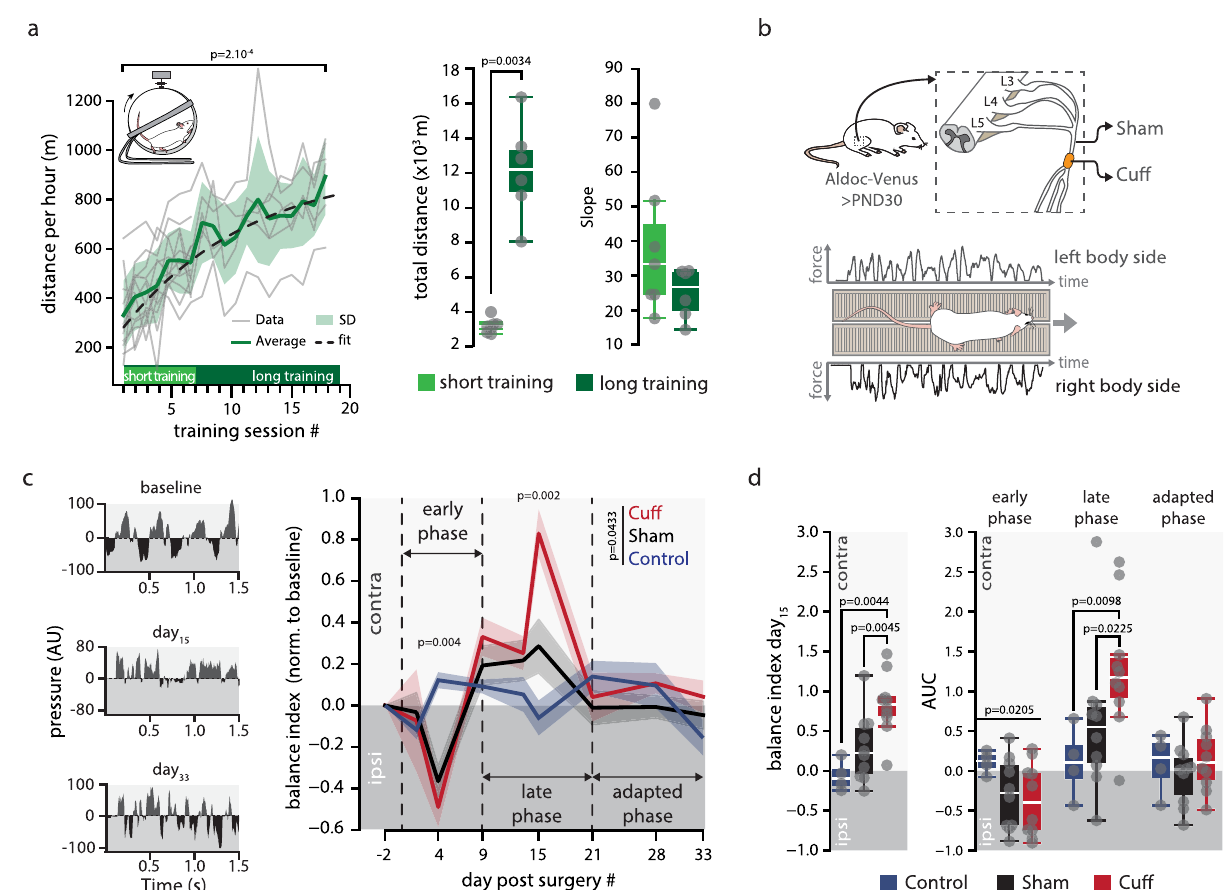
Fig. 3 Locomotor adaptation in different contexts. a Left panel, distance traveled by mice in the wheel across sessions. Short training: 1 h/day for 7 consecutive days, n (mice) = 7; long training: 1 h/day for 19 consecutive days, n = 6. Two-tailed paired t -test between training session #1 and training session #19, p -value in graph. Dashed line, logistic regression, p = 2.75 × 10 − 26 . Right panels, total distance and slope of the distance across sessions for short ( n = 6) and long ( n = 7) training animals. Total distance mean ± SD in km: short training, 3.1 ± 0.4; long training, 12.2 ± 2.6. Slope mean ± SD in m/ session: short training, 38.6 ± 19.8; long training, 24.9 ± 6.7. Whisker bounds: minima/maxima, median, interquartile range. Two-sided MWU, p -value in graph. P > 0.05 in Source Data. b Upper panel, cuff model of locomotor impairment. In cuff animals, a 2-mm-long polyethylene cylinder (cuff) was surgically wrapped around the main branch of the right sciatic nerve. Sham animals underwent only surgeries. Lower panel, illustration of a trial on the force pressure corridor. c Balance de fi cits in cuff ( n = 10) and sham ( n = 10) groups. Left panel, examples of raw data measurements from the force-sensor corridor in a cuffed mouse before surgery (baseline), 15 days after surgery and 33 days after surgery. AU, arbitrary unit. Balance Index (BI) corresponds to the log of the ratio of the integrated force-signal from each side of the body. Right panel, averaged (±SEM) time-course of the BI in cuffed ( n = 10, red), sham ( n = 10, black), and controls ( n = 4, blue). Values were normalized to baseline. Early phase, from day 0 to day 9 post surgery; late phase, from day 9 – 21 post surgery; adapted phase, from 21 days post-surgery. One-way repeated measurements MANOVA from day 2 – 28, F = 2.16; post hoc ANOVA, early phase/late phase, F = 7.17/ F = 8.23, p -values in graph. d Left panel, normalized BI measured at Day 15 post surgery. Mean ± SD: control, − 0.06 ± 0.19 ( n = 4); cuff, 0.83 ± 0.37 ( n = 10); sham, 0.29 ± 0.43 ( n = 10). Whisker bounds, same as in a. KW (all groups), p = 0.00354; post hoc two-sided MWU, p -values in graph. Right panel, area under the curves (AUC) of balance time course shown in c for cuffed, sham and control groups. Mean ± SD in early phase: control, 0.1 ± 0.1; cuff, − 0.4 ± 0.4; sham, − 0.3 ± 0.4. Mean ± SD in late phase: control, 0.1 ± 0.4; cuff, 1.3 ± 0.8; sham, 0.6 ± 0.9. Mean± SD in adapted phase: control, 0.08 ± 0.3; cuff, 0.14 ± 0.4; sham, − 0.03 ± 0.4. Whisker bounds same as in a . Levene ’ s test, early phase, p = 0.0205; two-sided MWU, p -values in graph. P > 0.05 in Source Data. Source data are provided as a Source Data fi